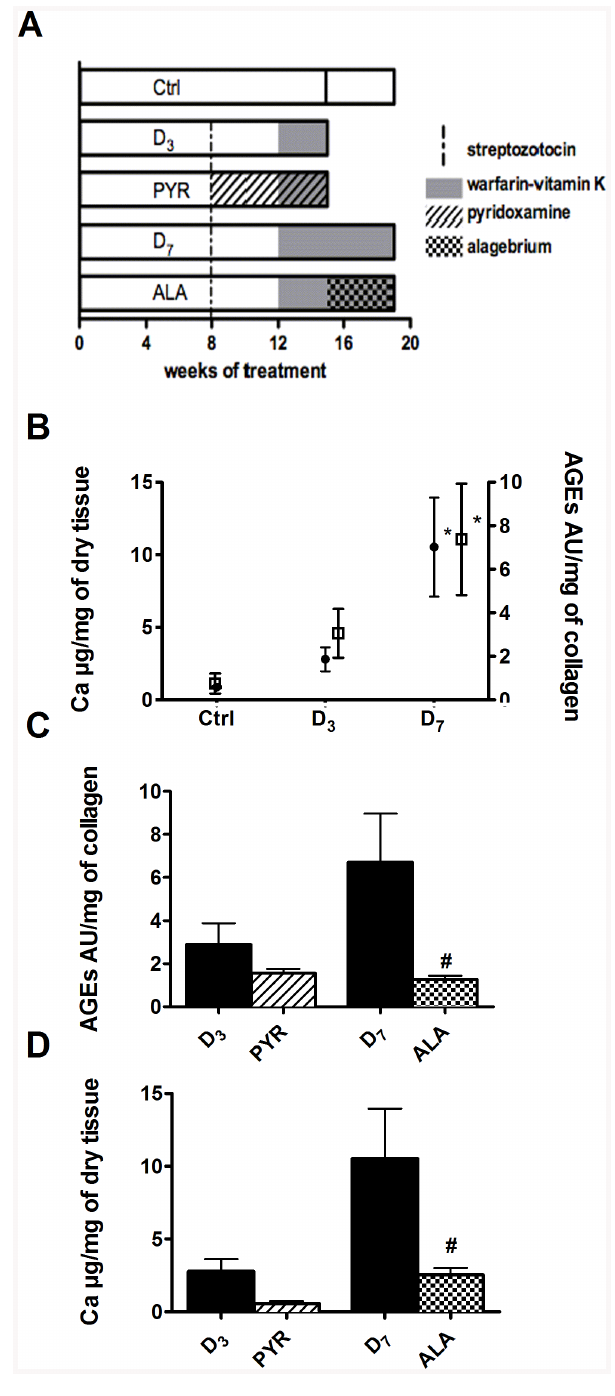
Figure 1. Implication of AGEs in diabetes-accelerated femoral calcification in vivo. (A) Treatment scheme. Open bars represent a high fat diet, diagonals represent the pyridoxamine treatment while white and black squares are for the alagebrium treatment. The gray bars show the warfarin/vitamin K treatment and the number exponent on D indicates the duration in week of WVK treatment. The vertical dashed lines represent the injection of streptozotocin. (B) Quantification of fluorescent advanced glycation end-products (open squares) and calcium (closed circles) accumulated in femoral vascular wall. (* p , 0.05 vs Ctrl). Effect of pyridoxamine (PYR) and alagebrium (ALA) on (C) AGEs and (D) calcium accumulation in femoral arteries. ( # p , 0.05 vs D7). For convenience and because no hemodynamic differences were